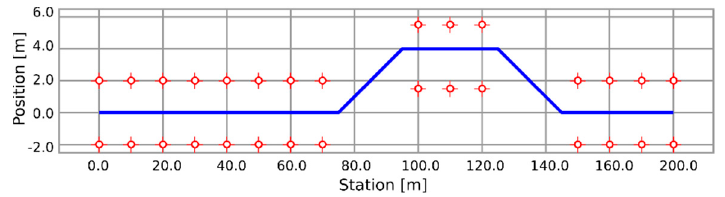
Figure 14. Road during maneuverability test.